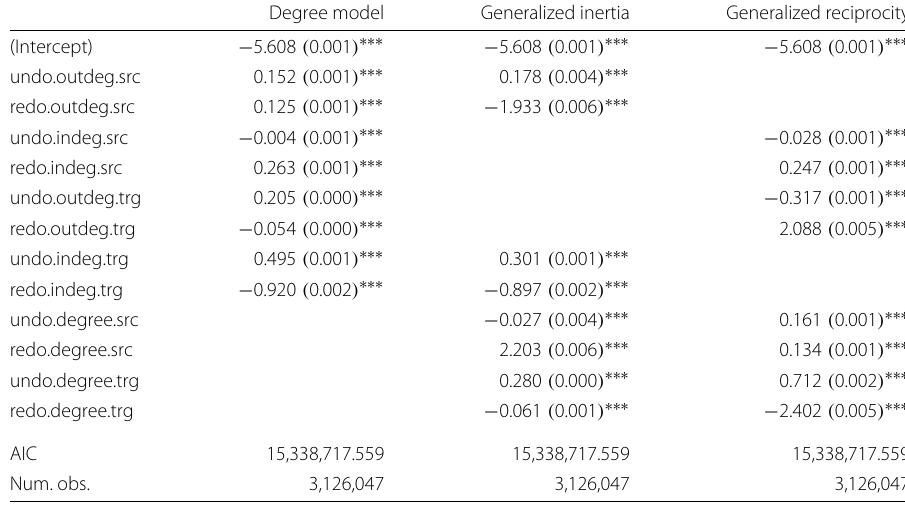
Table 6 Explaining dyadic undo by past undo and redo on dyads incident to source and target (degree effects) Degree model Generalized